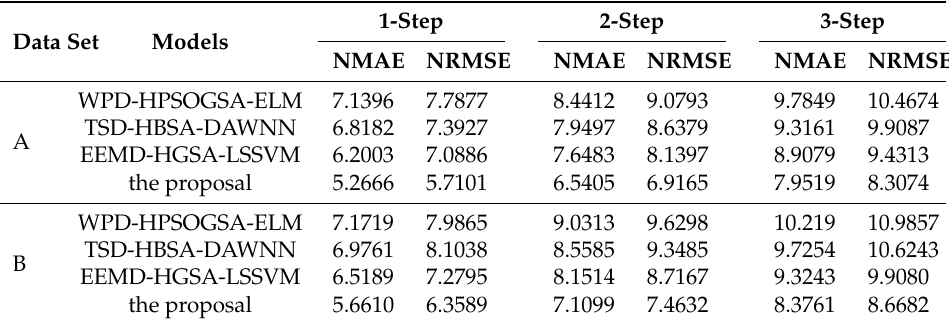
Table 7. Forecasting results obtained by the recently developed models (%).